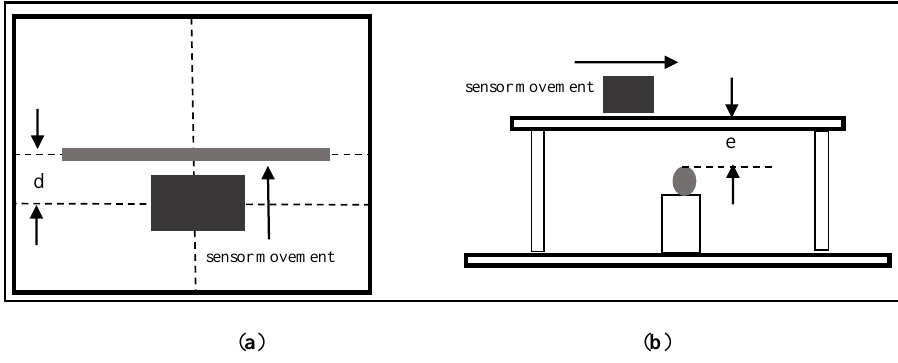
Figure 12. Schematic representation of the movement of the sensor: ( a ) top view; ( b ) side view.